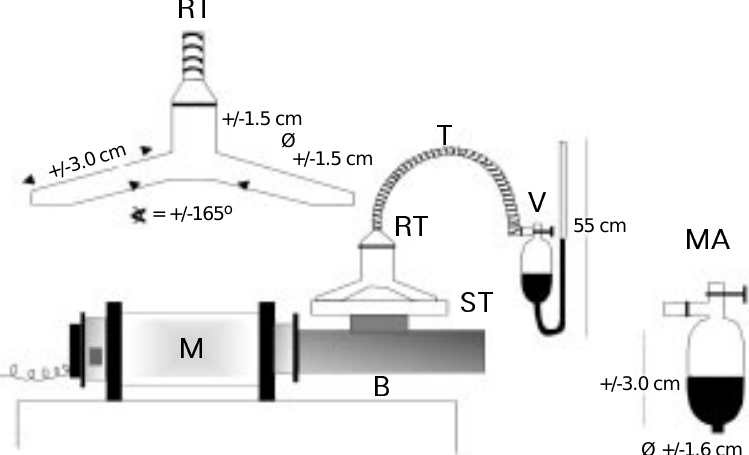
Figure 1 - Device for the measurement of oxygen evolution. The reaction test tube (RT) is held by a support (ST), connected to the stirrer motor (M) through a steel bar (B). RT is connected to the manometer (MA) by a rubber tubing (T). The bulb of the manometer is provided with a valve (V) to equilibrate the system with the atmospheric pressure before mixing the reagents. RT total capacity is 12.0